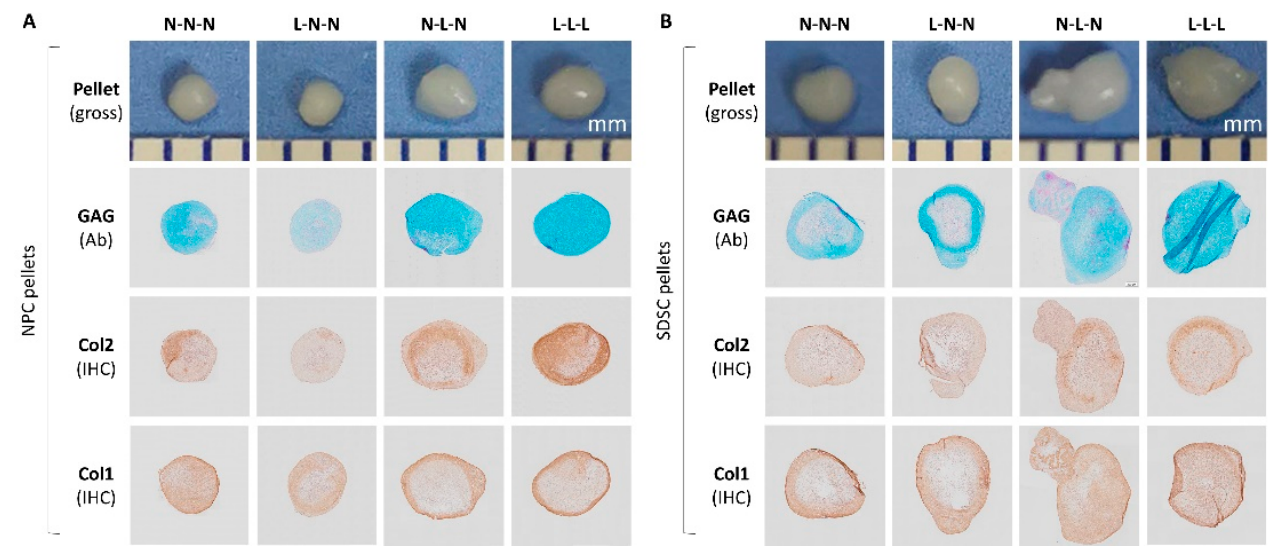
Figure 4. Evaluation of the effect of hypoxia pretreatment on the chondrogenic potential of fetal MSCs using histology and immunohistochemical staining. NPC ( A ) and SDSC ( B ) pellets were cultured in chondrogenic induction medium for 21 days. Hypoxia was used in cell expansion and subsequent induction in different combinations (see Figure 1A). Histology using Alcian blue staining (Ab) for sulfated GAG (with fast red as a counterstain) and immunohistochemical staining (IHC) for type II collagen (Col2) and type I collagen (Col1) (with hematoxylin as a counterstain) along with a gross photo to indicate the size of the pellet (mm).